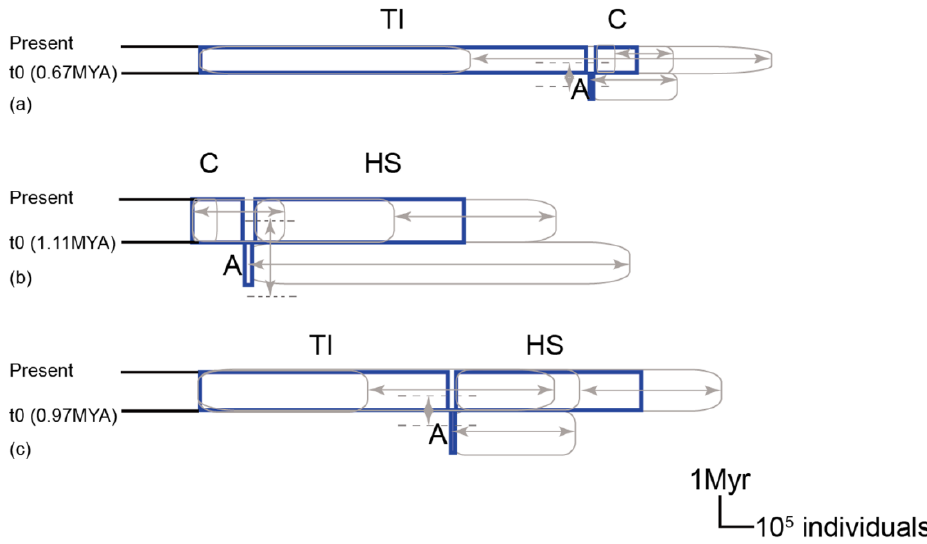
Figure 6. Population divergence process among assigned C. ramondioides groups inferred from a pairwise IMa2 analysis. The group codes, figure labels, and figure format correspond to Figure 5. Scale bars for 100,000 individuals and 1 million years apply to all six plots. ( a ) The estimated divergence process between TI and C group. ( b ) The estimated divergence process between C and HS group. ( c ) The estimated divergence process between TI and HS group.